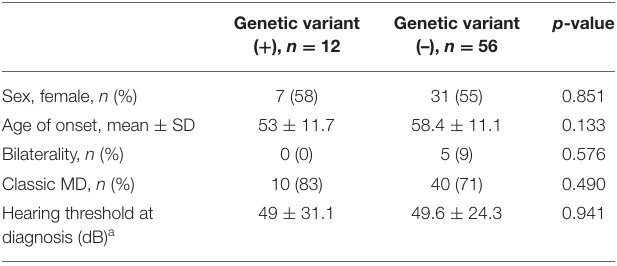
TABLE 3 | Phenotypic differences between patients with and without a genetic variant.